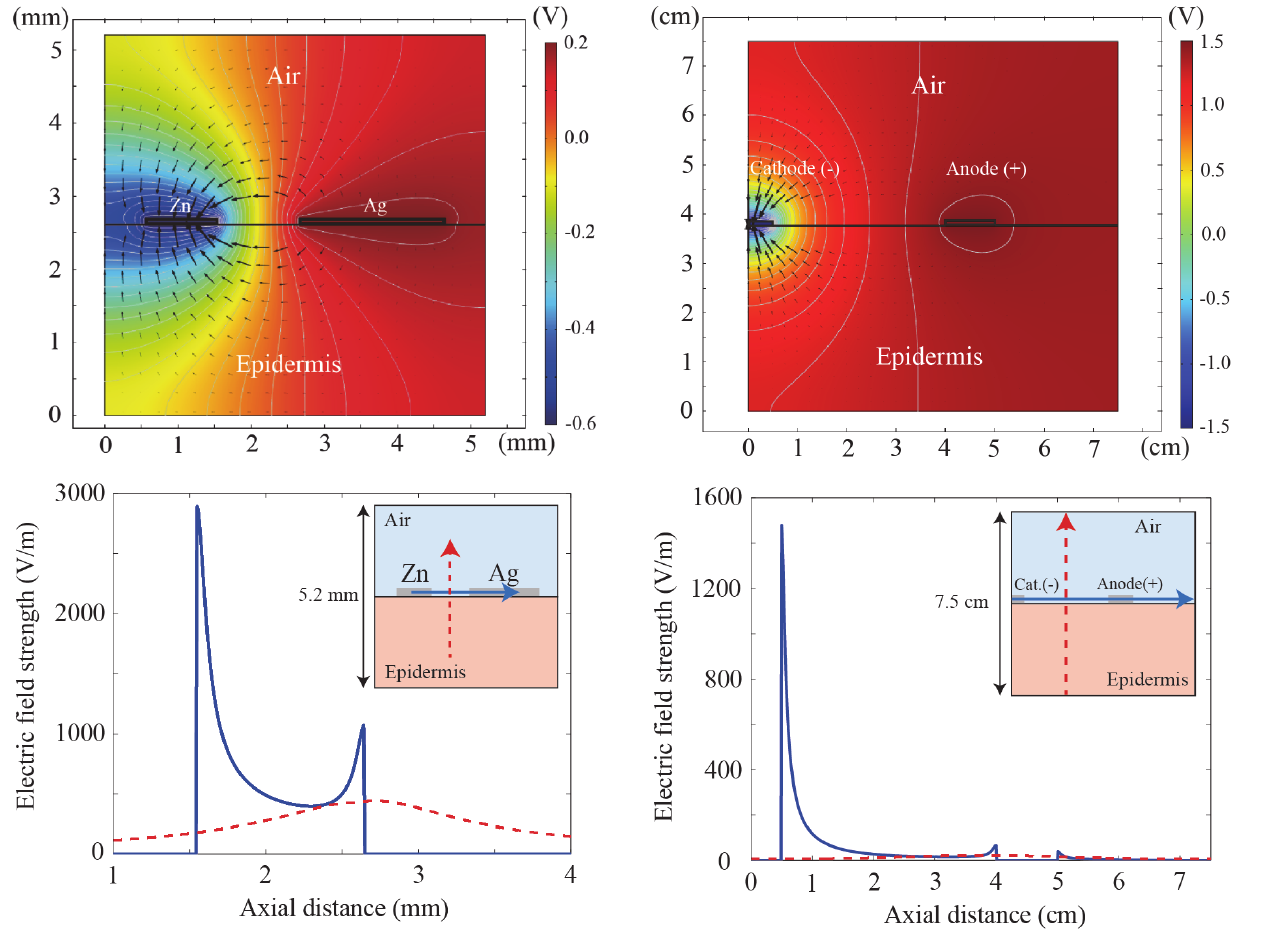
Fig.2: (top) Equipotential lines (the colors represent electrical potential according to the scale to the right) and corresponding electric field vectors for a representative cross-section through a Procellera ® dressing model in the form of rings of alternating metals with length scales in accordance with the real dressing. Ag dots at potential +0.2 V is twice the width of the Zn dots at the potential -0.6 V. They are separated a distance which is slightly larger than the Zn width. The metal rings are sitting on epidermis and have air on top. Notice the strong crowding of equipotential lines between Ag-Zn corresponding to a large electric field of the order of 1 kV/m as is detailed in the bottom figure, for clarity. (bottom) Detailed electric field plot. Notice as we move between Zn and Ag dots the field is of the order of 1 kV/m (solid blue). In the perpendicular direction it peaks at around 400 V/m and drops off into air and epidermis (dashed red). The blue line starts at x=1 mm and ends at 4 mm. In the same way the red one starts at y=1 mm, ends at 4 mm in the direction perpendicular to the dressing and passes directly in the middle of the two dots.